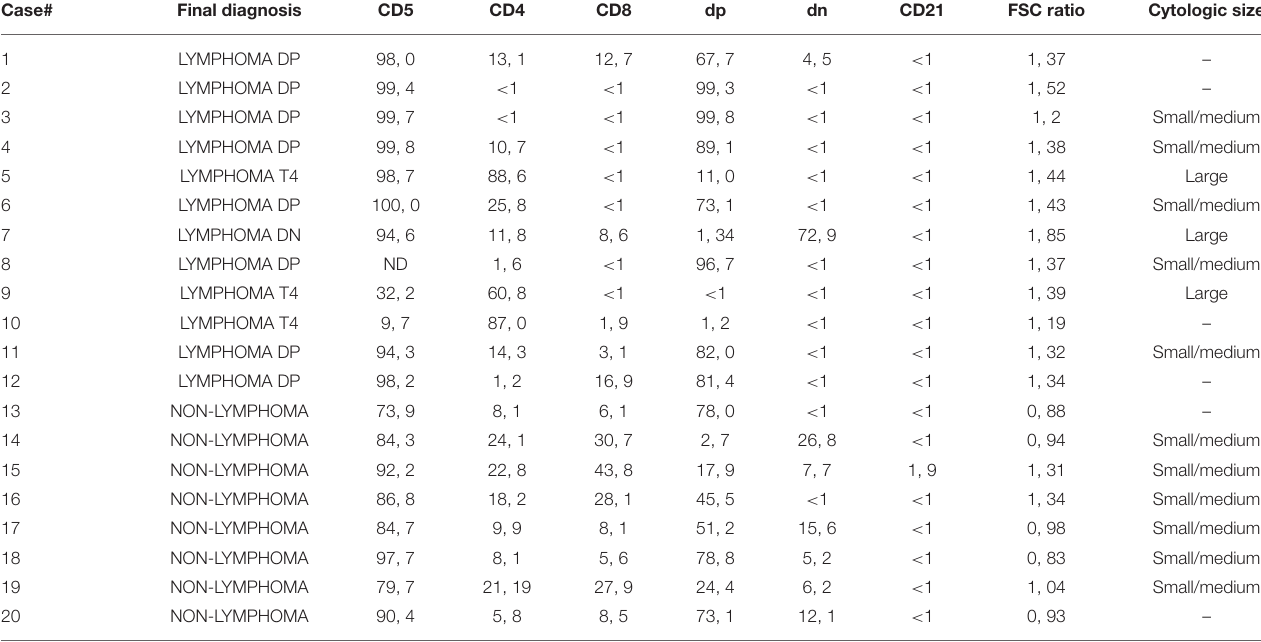
TABLE 3 | Lymphoid